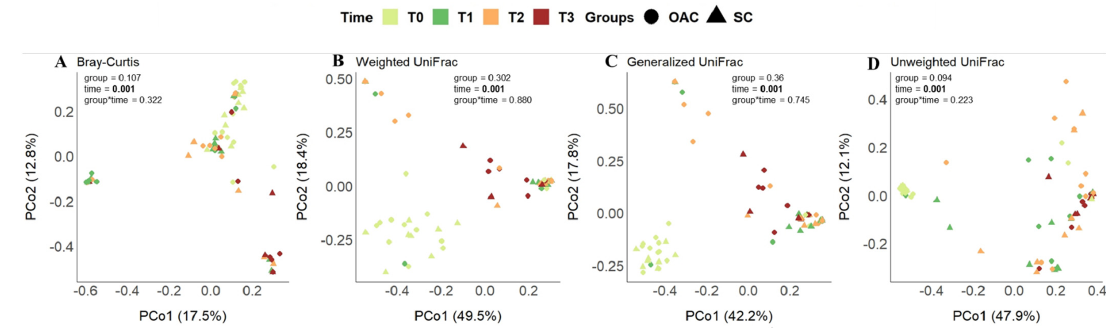
Figure 5. Beta diversity distances (Bray–Curtis—( A ); Weighted UniFrac—( B ); Generalized UniFrac—( C ) and Unweighted UniFrac—( D )) between groups over time. Legend: OAC (Oropharyngeal Administration of Colostrum); SC (Standard Care); T0 (first day of life), T1 (7 days after birth), Time 2 (14 days after birth), Time 3 (21 days after birth).